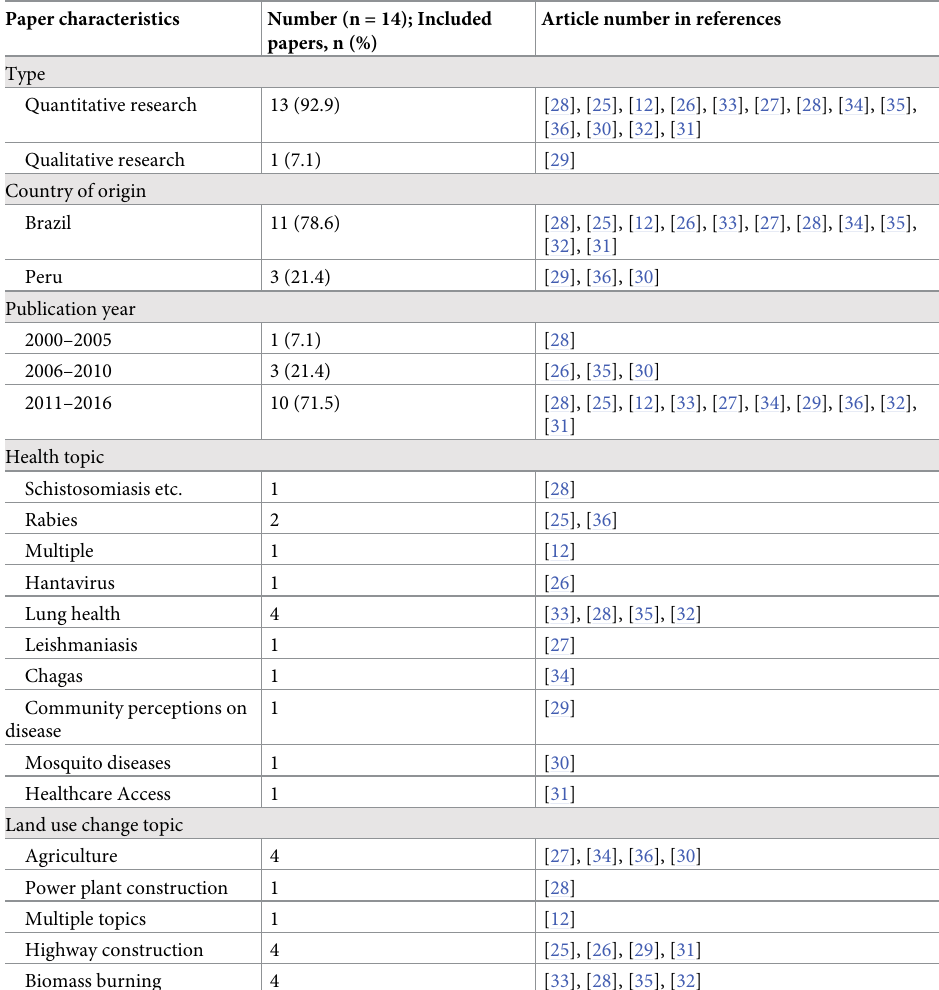
Table 3. Basic details of included